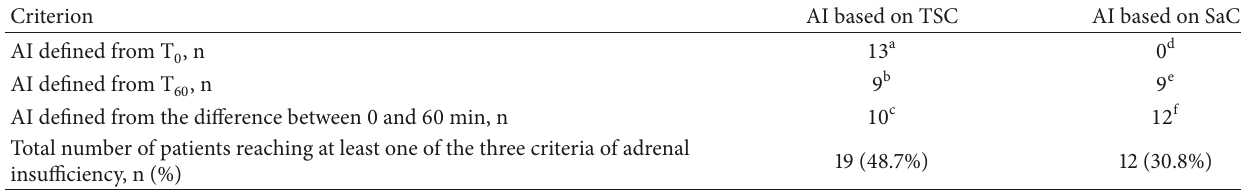
AI defined from the difference between 0 and 60 min, n Total number of patients reaching at least one of the three criteria of adrenal insufficiency, n (%) AI, adrenal insufficiency; TSC, total serum cortisol; SaC, salivary cortisol; T 0 , baseline; T 60 , 60 min after administration. To convert cortisol micrograms per deciliter to nanomoles per liter, multiply by